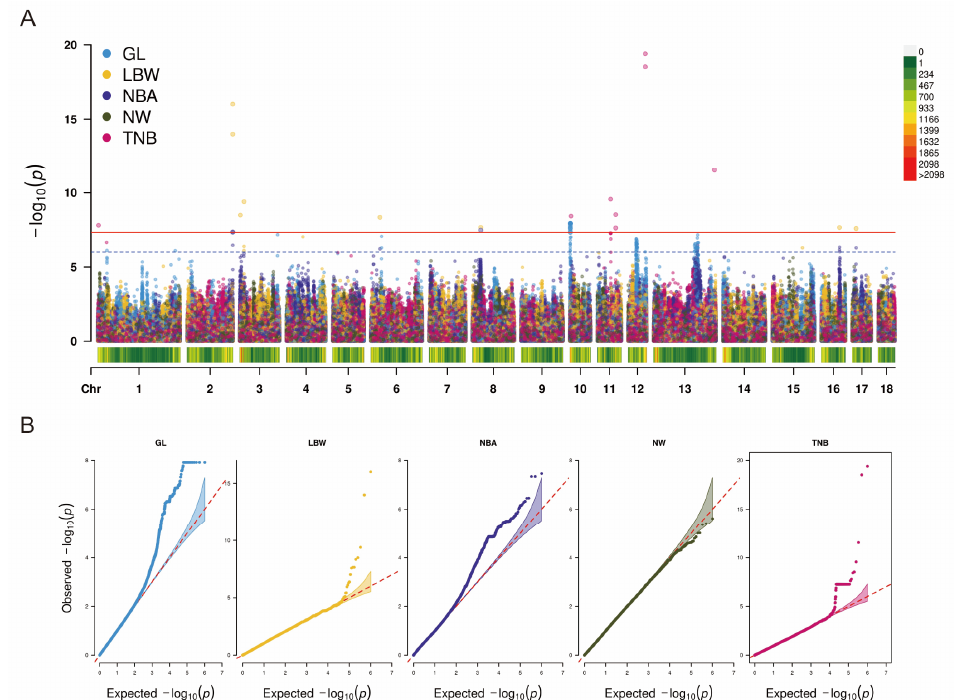
(Supplementary Table S4). Further, 43 SNPs reach the genome-wide significance level: 8 SNPs for TNB, 3 SNPs for NBA, 8 SNPs for LBW, and 24 SNPs for GL. These significant SNPs were annotated to a number of candidate genes associated with reproduction, such